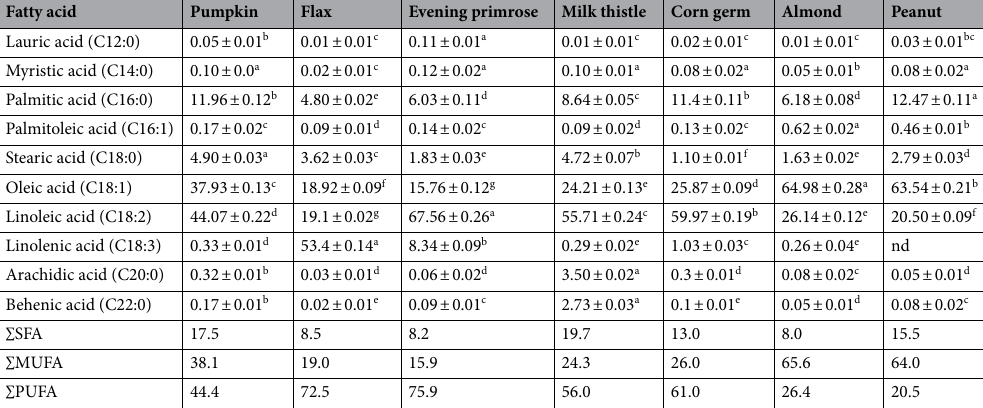
Table 4. Fatty acid composition (% of total fatty acid profile) of flours from oilseed cakes. MUFA monounsaturated fatty acids, PUFA polyunsaturated fatty acids, SFA saturated fatty acids. Values are means ± SD of three determinations. a,b,c,d,e,f,g The same letters within the same row were not significantly